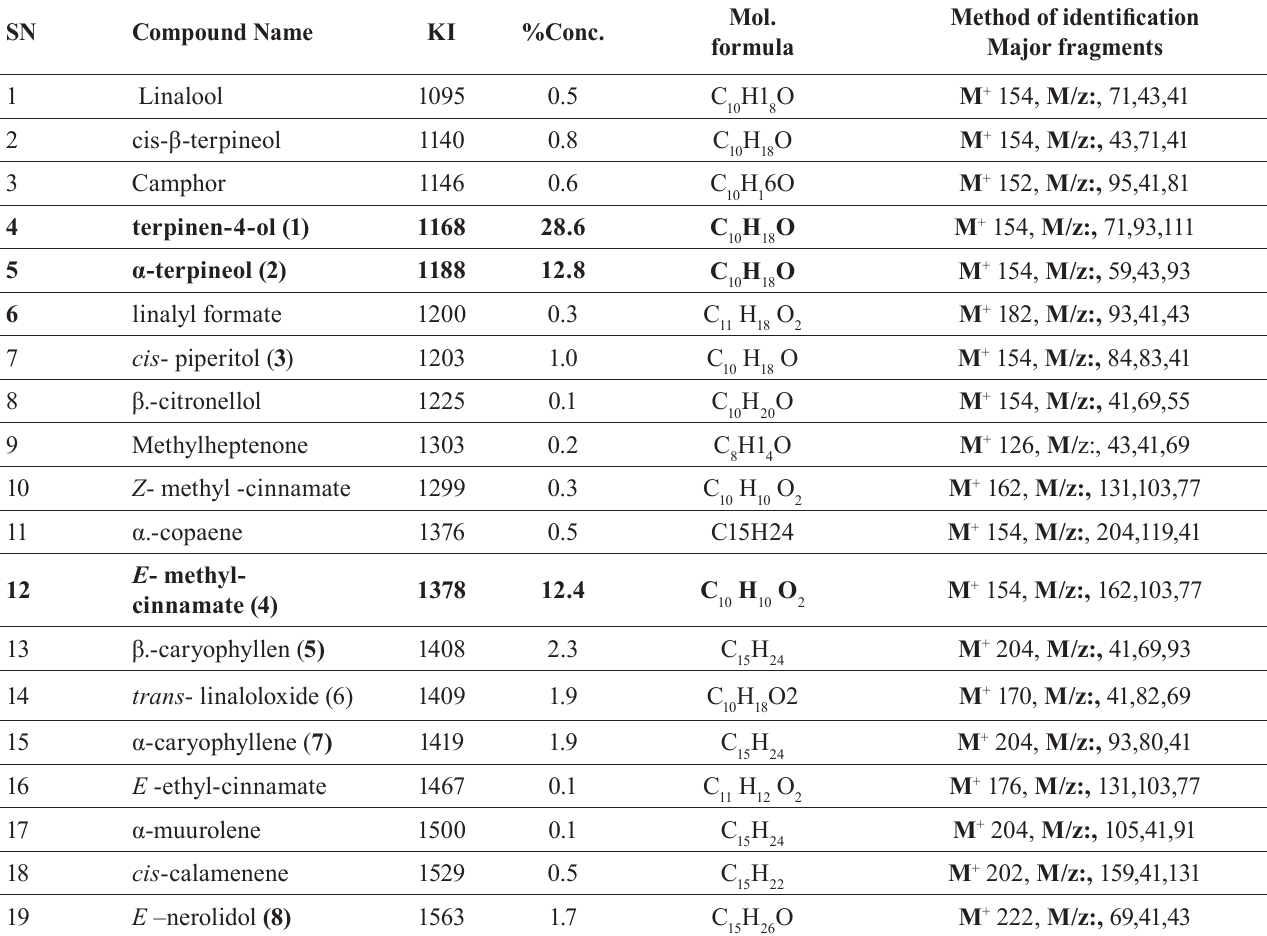
TABLE II - Chemical composition of